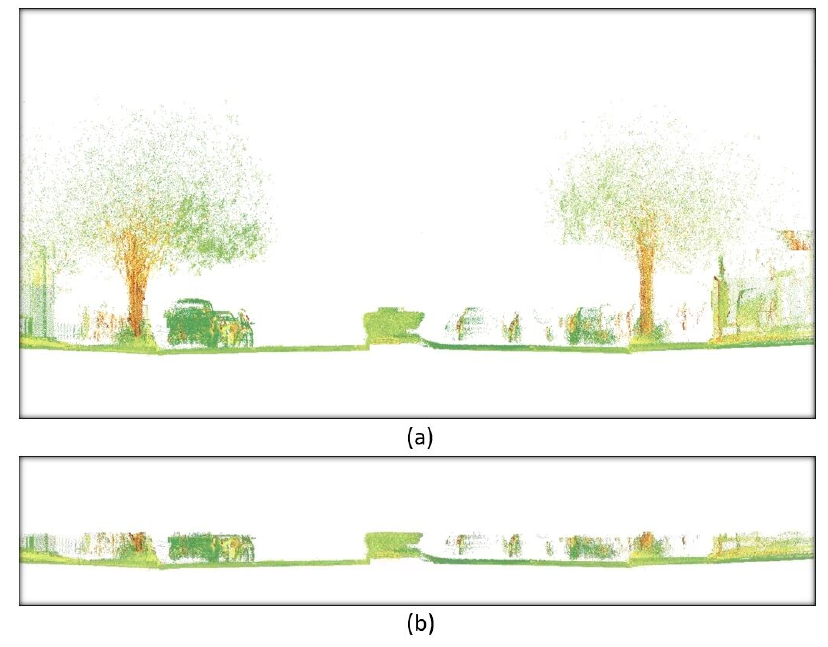
Figure 5. Elevation filtering in an urban area ( a , b